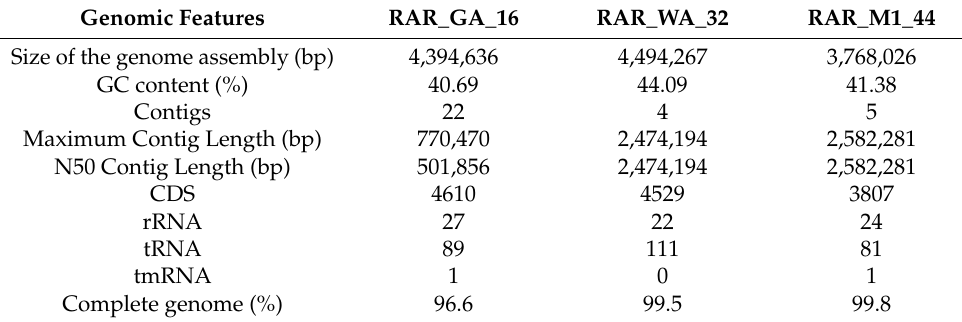
Table 7. Genomic features of the bacterial endophytes.